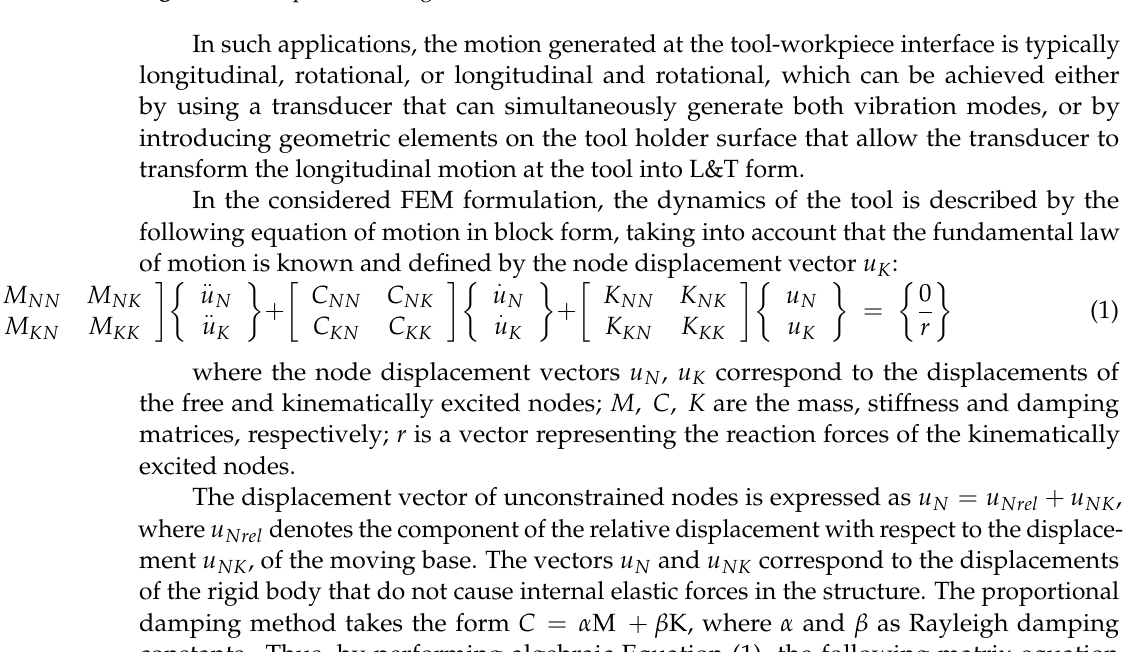
Figure 3. Principal block diagram of the FEM simulation